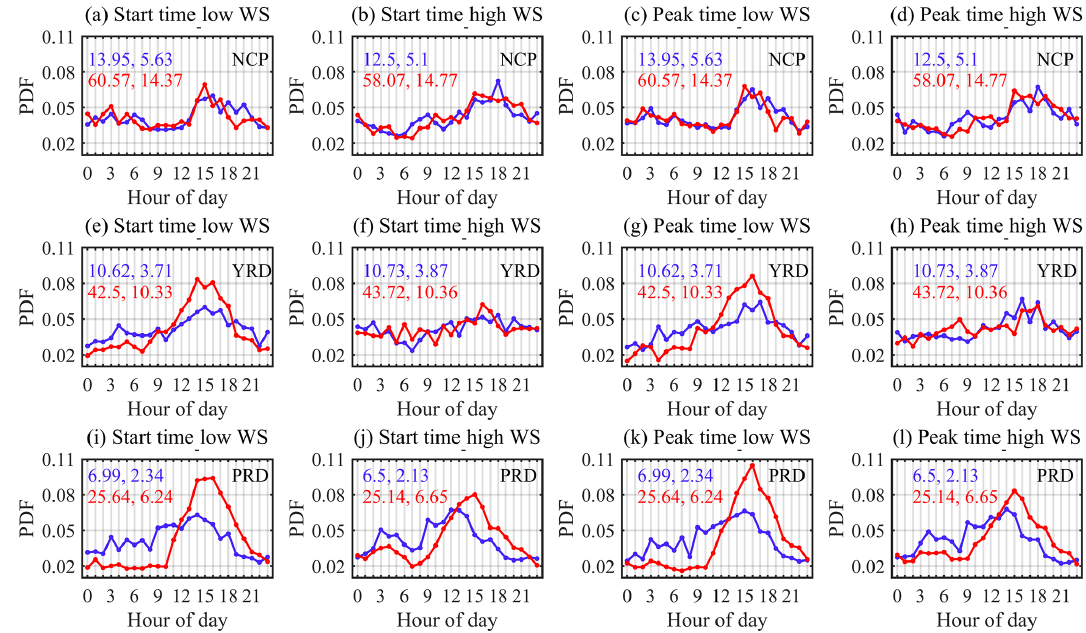
Figure 12. Same as Fig. 10, but under low-WS conditions and high-WS conditions. WS represents vertical wind shear between heights of 5500 and